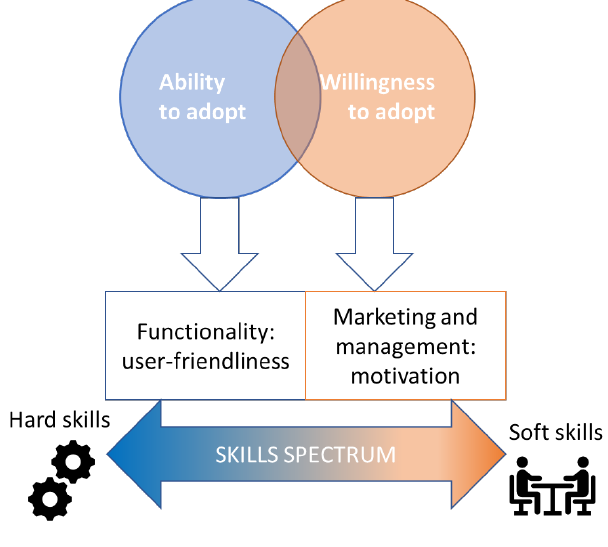
Figure 12. Overcoming restraining forces in blockchain